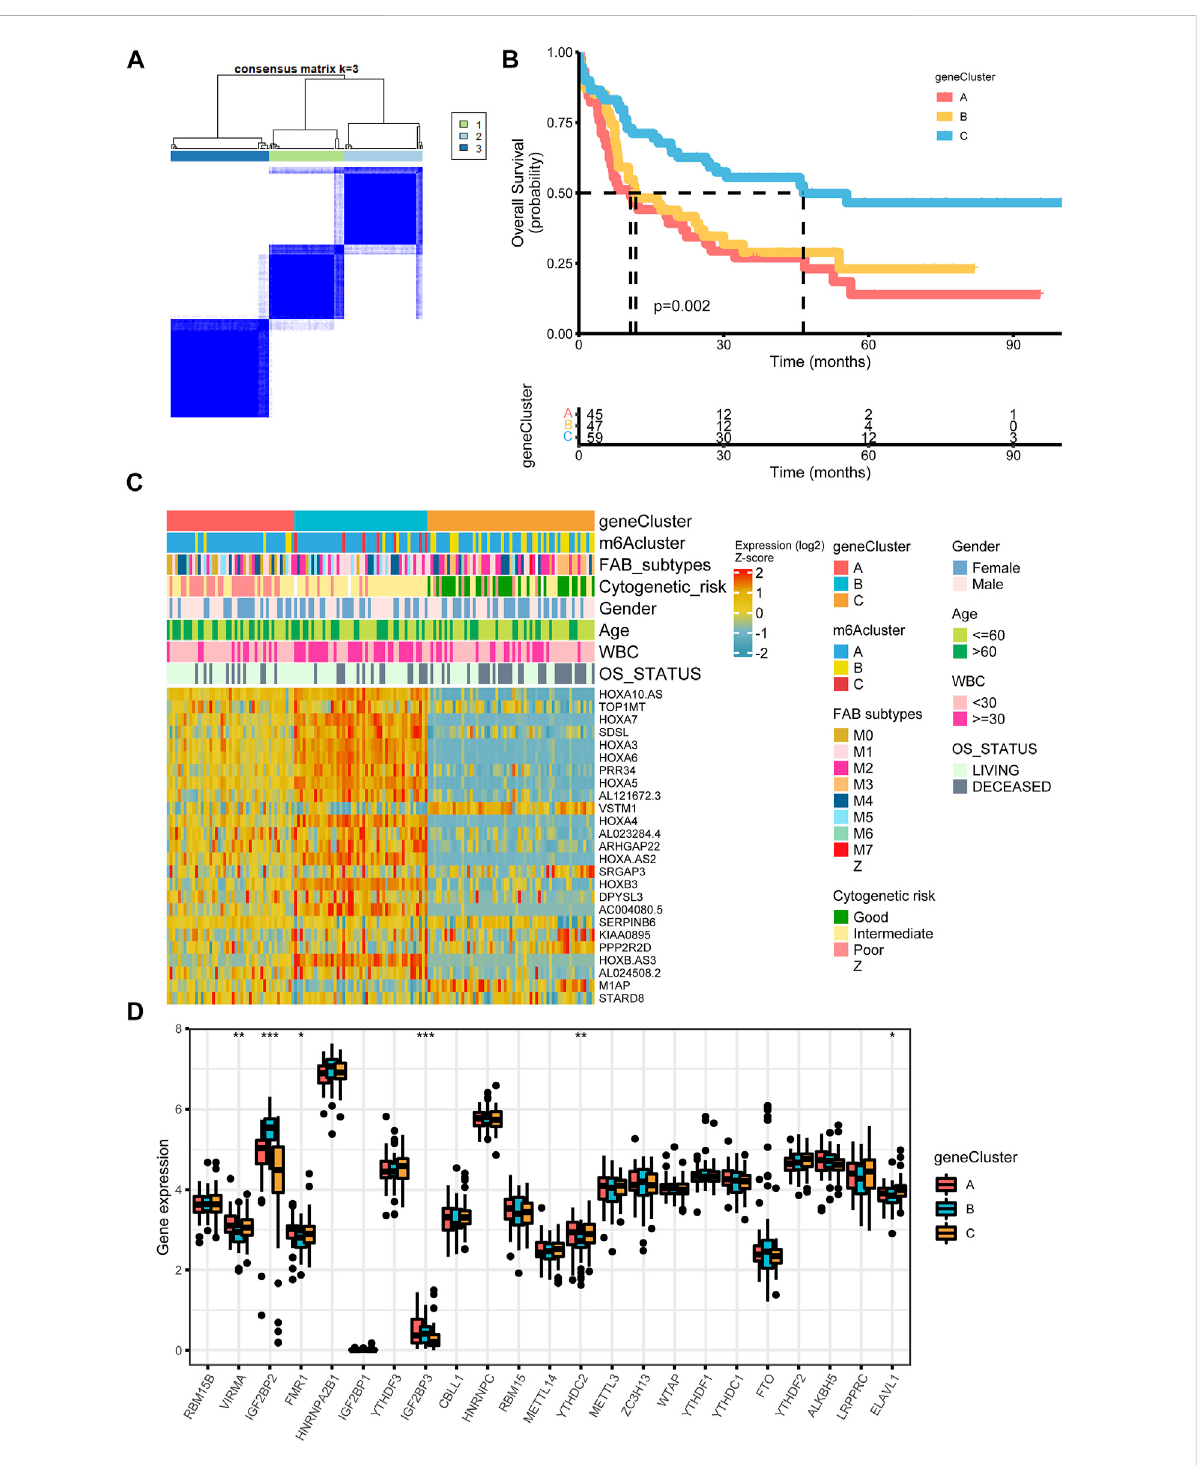
Construction of differential expression of m6A gene signatures (A) Unsupervised clustering of m6A phenotype-related genes in the TCGA cohort and consensus matrices for k =3 (B) Kaplan-Meier curves for overall survivalof them6A phenotype-related gene signatures ( p =0.002, Log- rank test) (C) Relationships between clinicopathologic features and the three genomic subtypes. The gene clusters, m6A clusters, FAB subtypes, cytogenetic risk, gender, age, white blood cell, and overall survival status were used as patient annotations (D) Differences in the expression